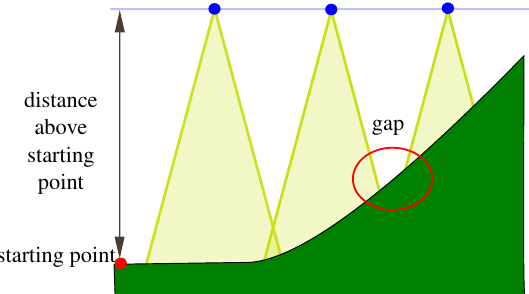
Figure 3: Scanning a hillside area while flying on a constant dis- tance above the starting point can lead to gaps in the